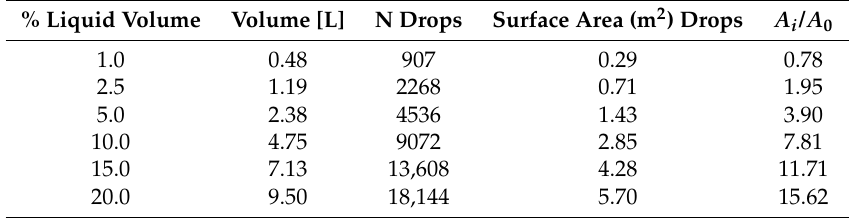
Table 3. Surface area for a number of liquid drops of 1 [cm] diameter equivalent to a percentage of the total liquid volume in the tank. Space between the drops are excluded. The undisturbed surface area is the same as in the large tank, equal to A 0 = 0.365 m 2